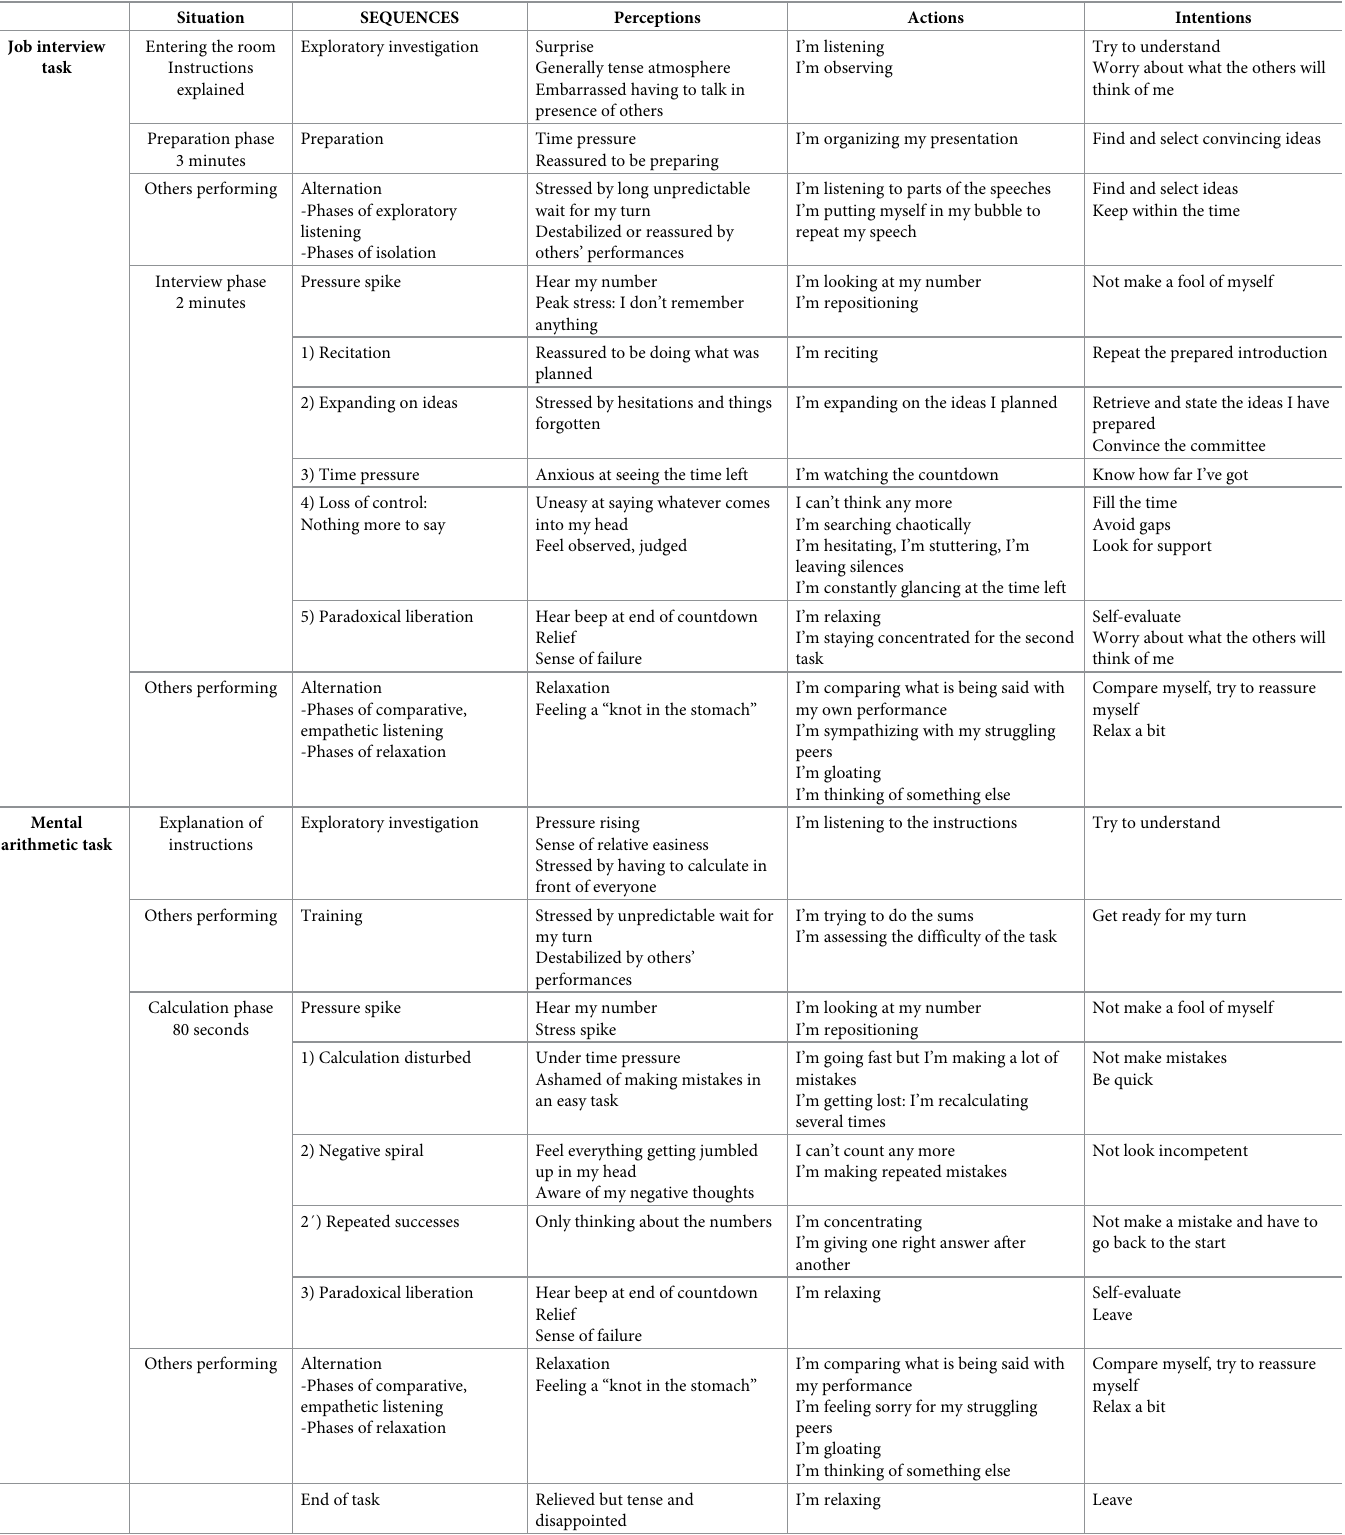
Table 4. Typical experience of the nine participants of the